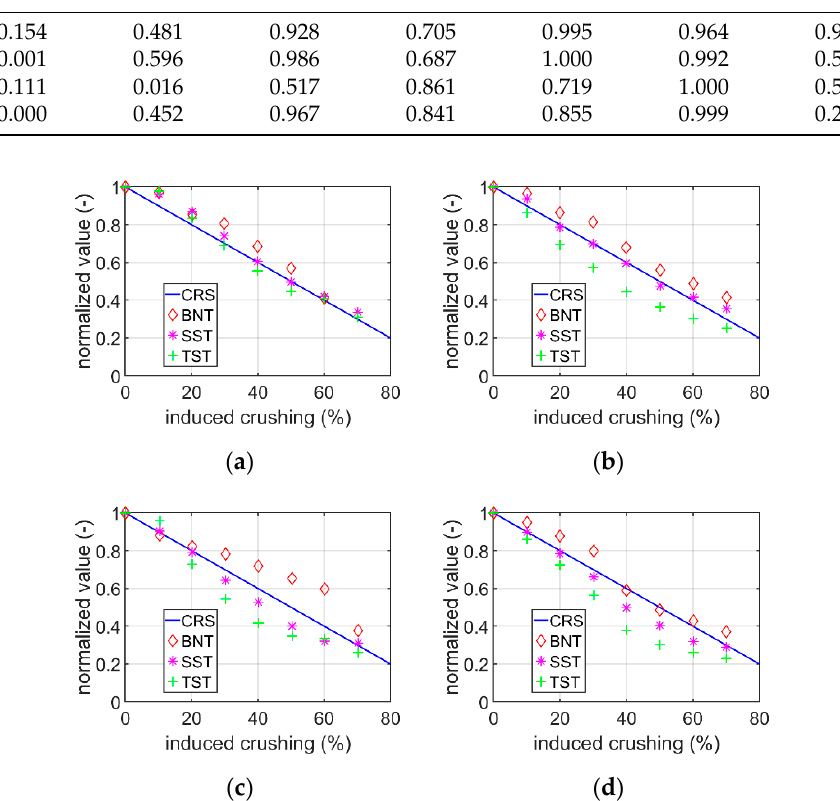
Table 3. The coefficient of determination 𝑅 (cid:2870) between crushing and normalized values.